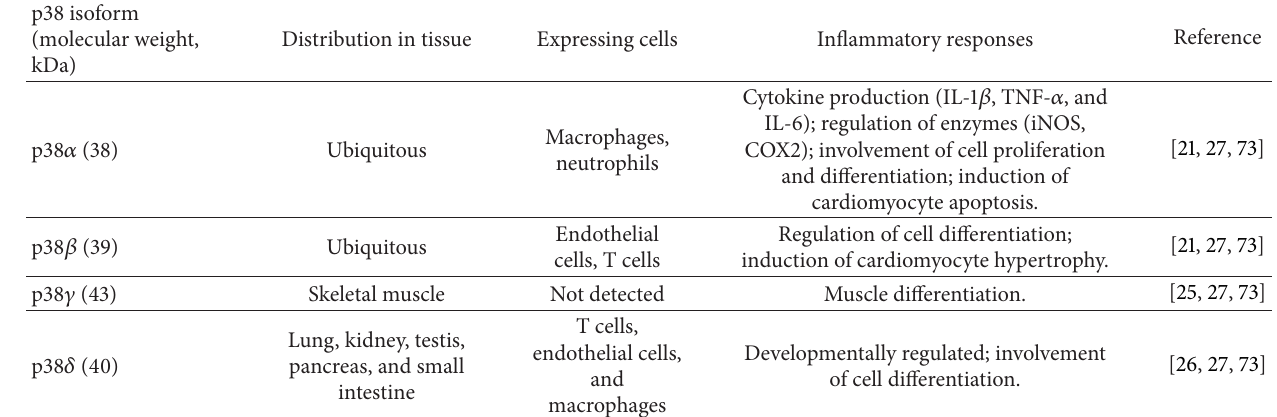
Table 1: p38 family members and their functions in inflammatory